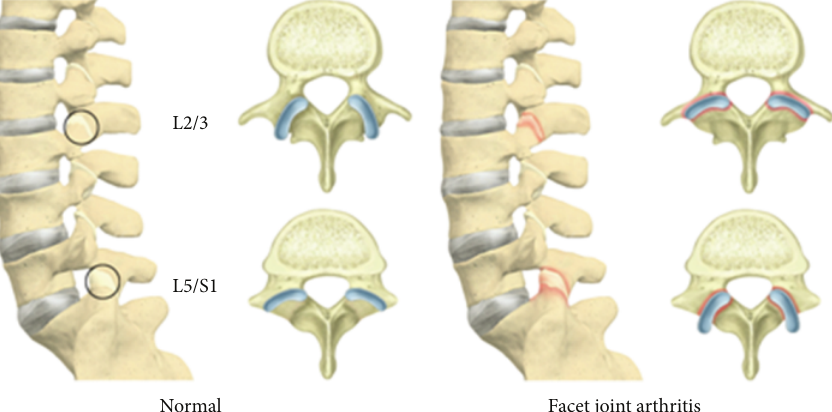
Figure 4: FJ arthritis and FJ orientation. On the left side, sagittally oriented FJs at L2/3 and coronally oriented FJ at L5/S1 are associated with normal FJs at the lumbar spine. The right side illustrates inversely oriented FJs with arthritic FJs at the lumbar spine, namely, coronals oriented FJs at L2/3 and sagittally oriented FJs at L5/S1.